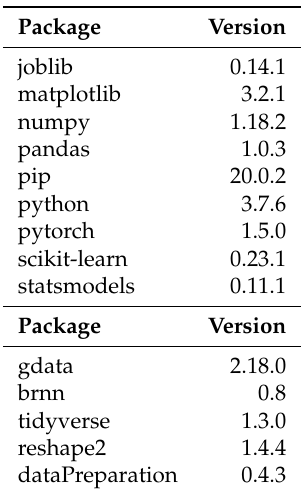
Table 4. List of Python (top) and R (bottom) libraries and respective versions installed on the